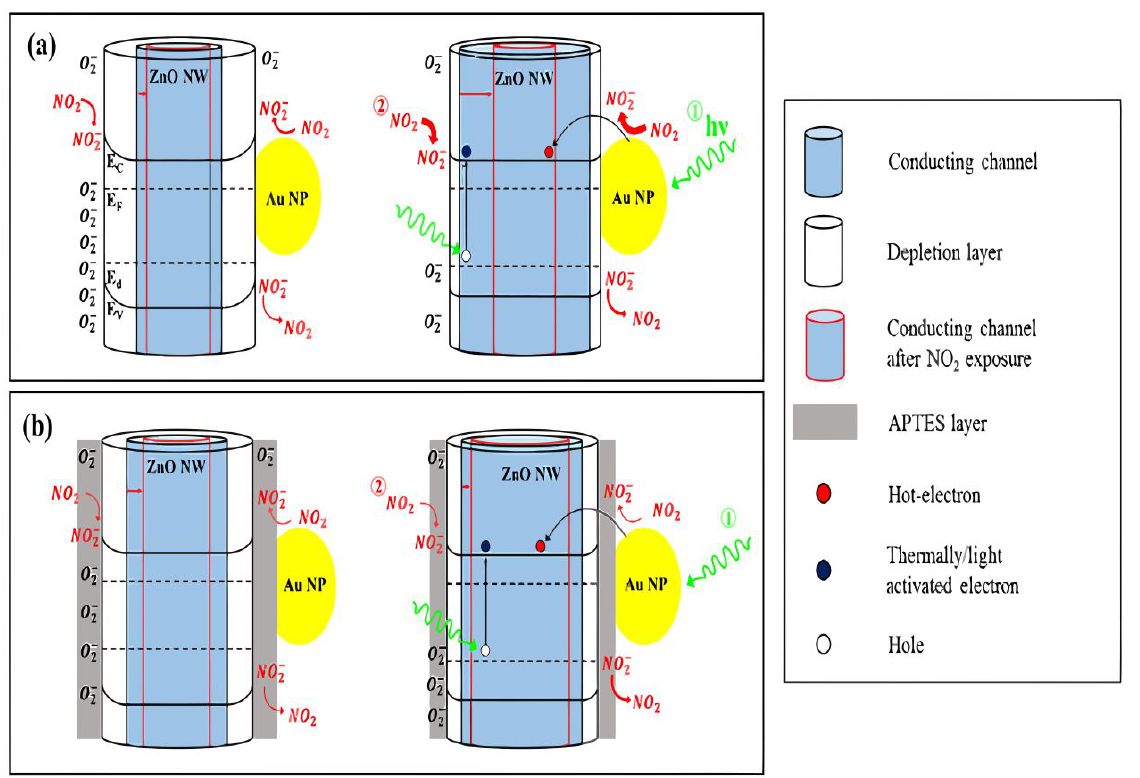
Figure 1. Schematic mechanisms for the enhanced NO 2 gas response of the Au nanoparticles-decorated ZnO nanowires, ( a ) without (Au – ZnO) and ( b ) with a (3-aminopropyl) triethoxysilane layer (Au – ZnO/APTES), in the dark ( left ) and under green illumination ( right ). The curved red arrows indicate the NO 2 gas adsorption and desorption processes, whose acceleration and diminishment are represented by the arrow thickness. The solid and dashed lines denote, respectively, the intrinsic conduction (EC) and valence (EV) bands and the Fermi (EF) and defect (Ed) levels. Reprinted with permission from Ref. [20].